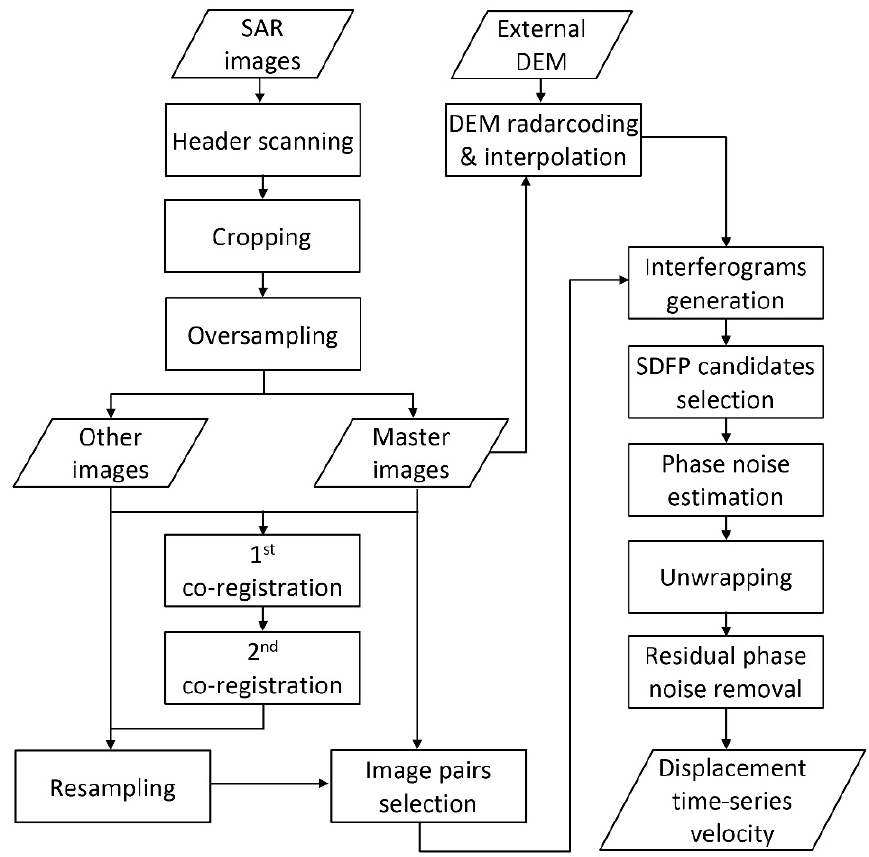
Figure 2. Flowchart of Small Baseline (SB) processing with image oversampling implemented.